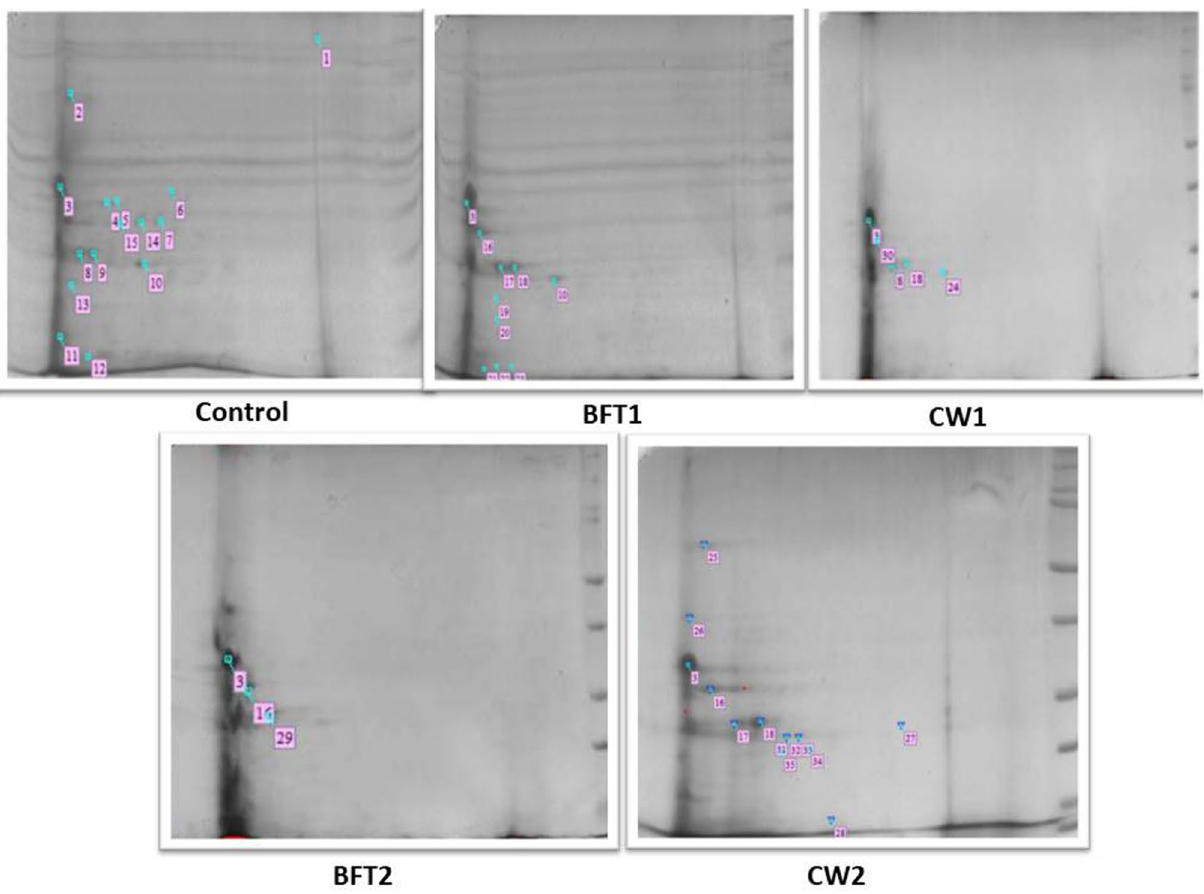
Figure 8. 2D gel electrophoresis of hepatopancreas samples taken from different treatments (uncropped whole blots of all replicates are provided in Supplementary Fig.